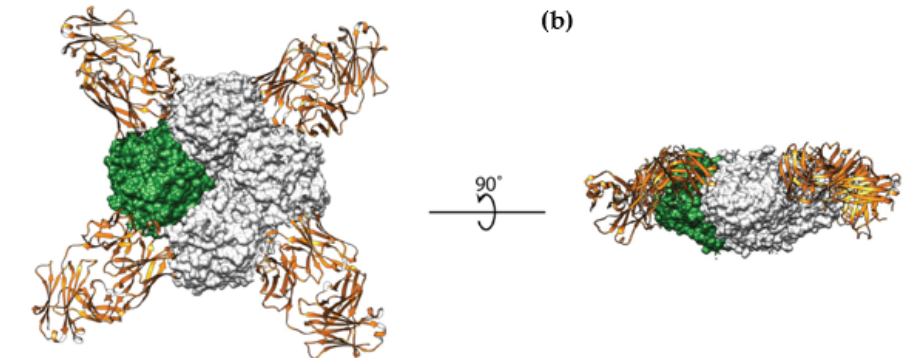
Figure 3. The structure of antibody CD6 in complex with influenza A virus neuraminidase (NA). ( a ) Top view of the NA–antibody complex. ( b ) Side view of the NA–antibody complex. Data retrieved from the Protein Data Bank (PDB ID 4QNP).